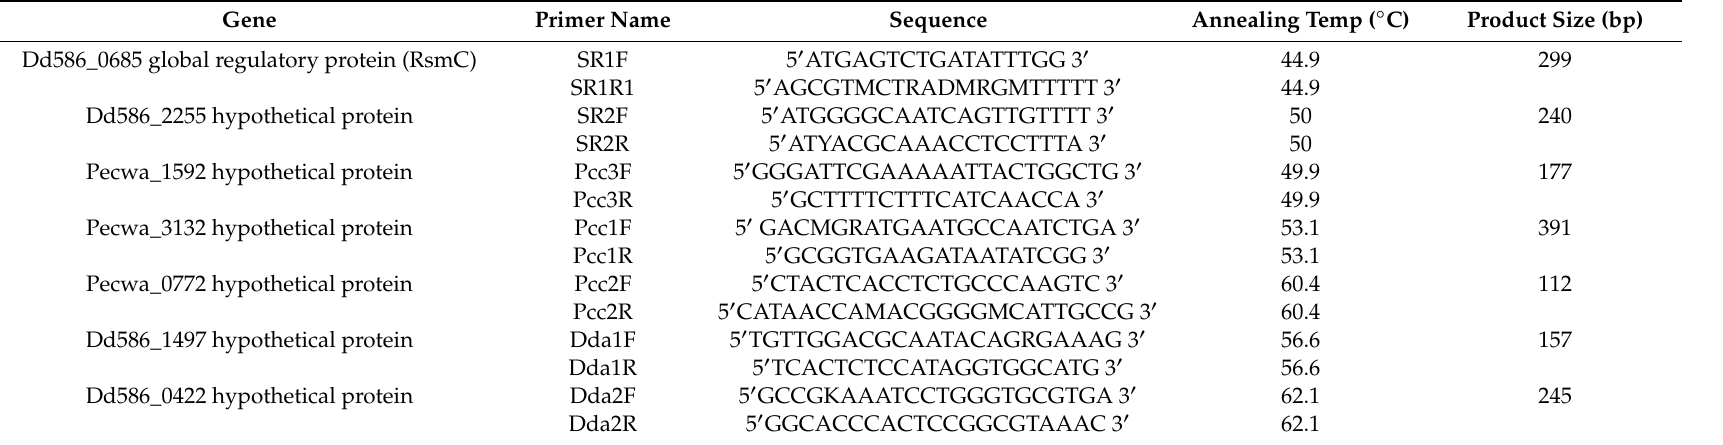
Table 1. List of oligonucleotide primers used for conventional PCR